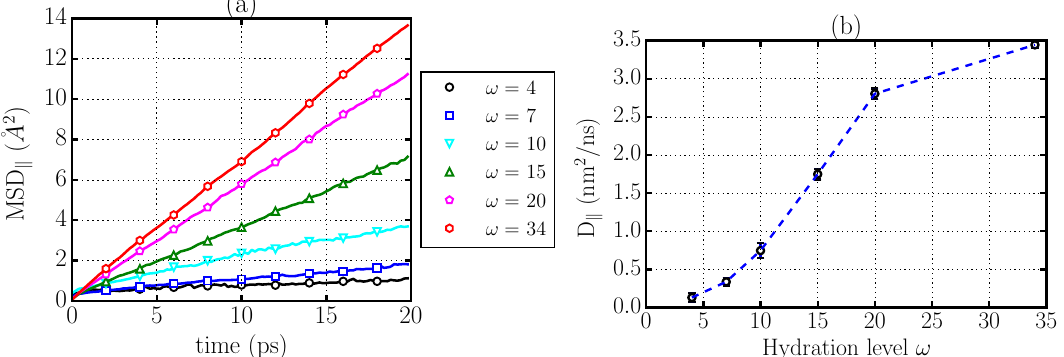
Figure 2. Translational dynamics of confined water molecules projected on the plane of the membrane for the different stacked phospholipid bilayers. ( a ) mean-square displacement on the plane of the membrane (MSD ) as a function of time; ( b ) diffusion coefficient of water molecules on the plane of the (cid:107) membrane for the different hydration levels